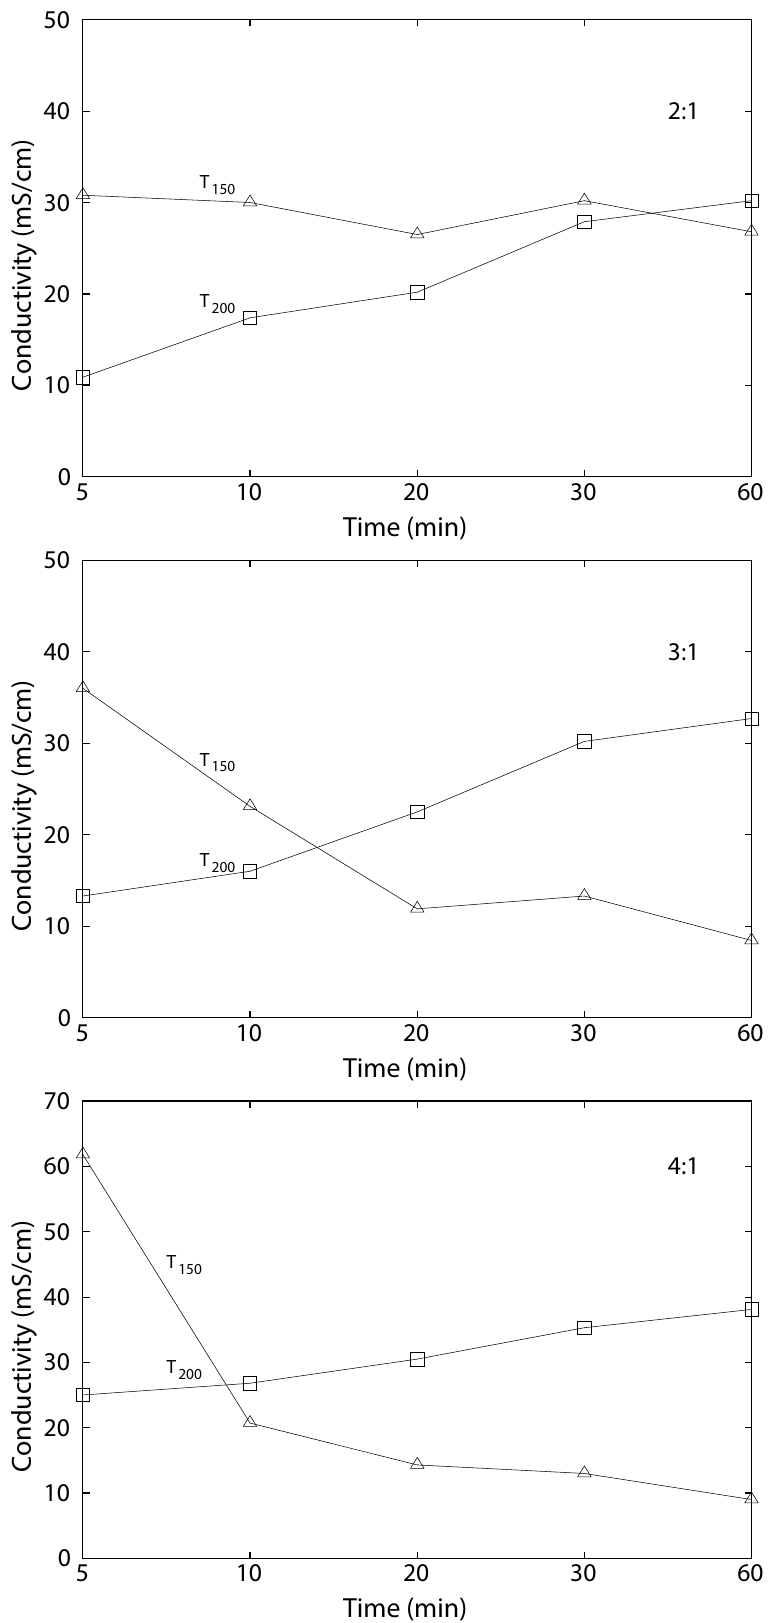
Figure 10. Conductivity of crosslinked SPEEK as a function of crosslinking time with different SPEEK:crosslinker ratios indicated in the upper right corner of the